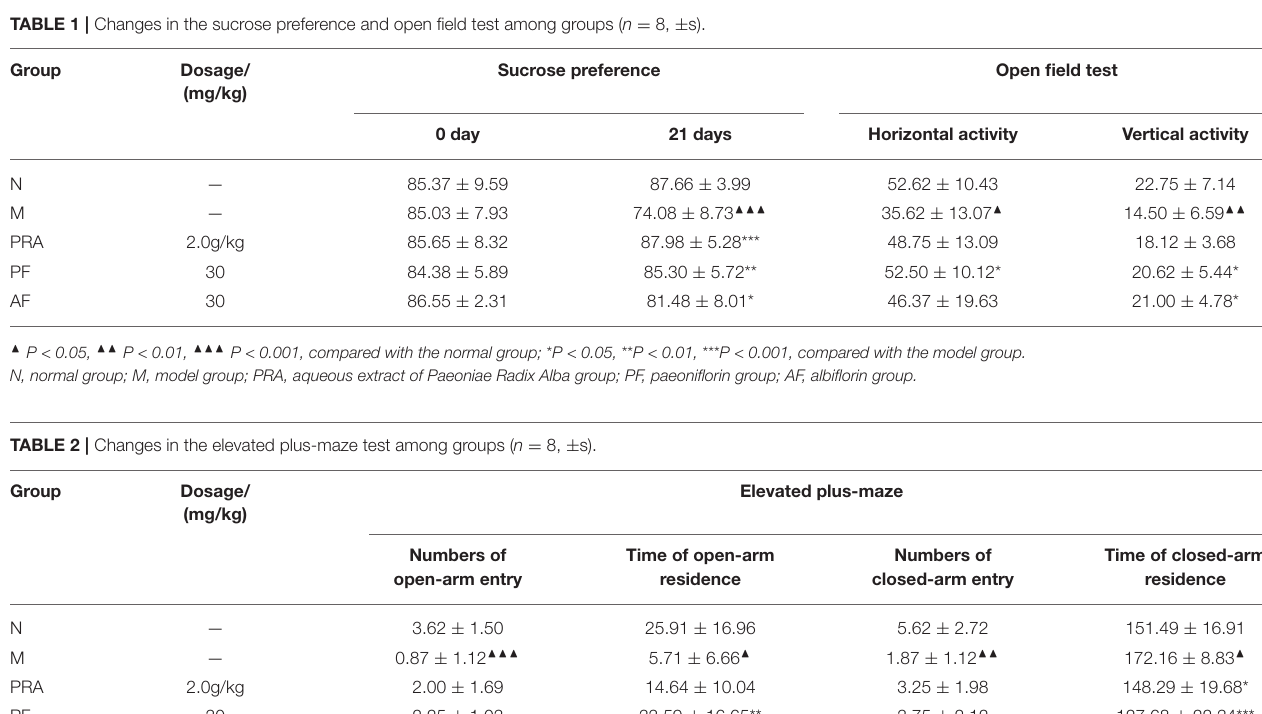
Numbers of open-arm entry